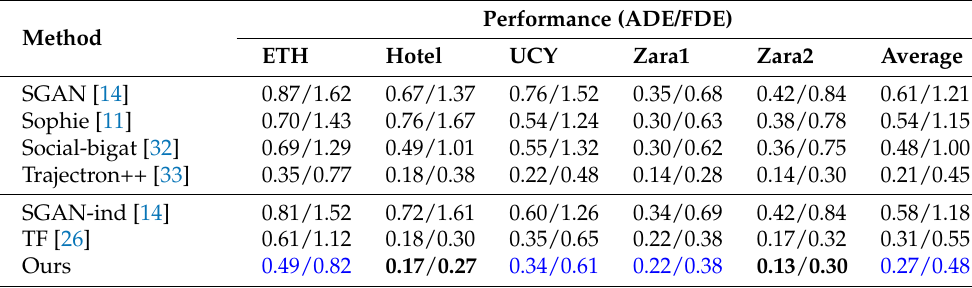
Table 3. Result comparison with the state of the art methods on ETH and UCY datasets following the best-of-20 protocol. The social-based and individual-based methods are shown in the top and bottom parts of the table, respectively. We achieve the best performance in the ADE and FDE on the Hotel dataset and FDE on Zara2, compared with the social-based and individual-based